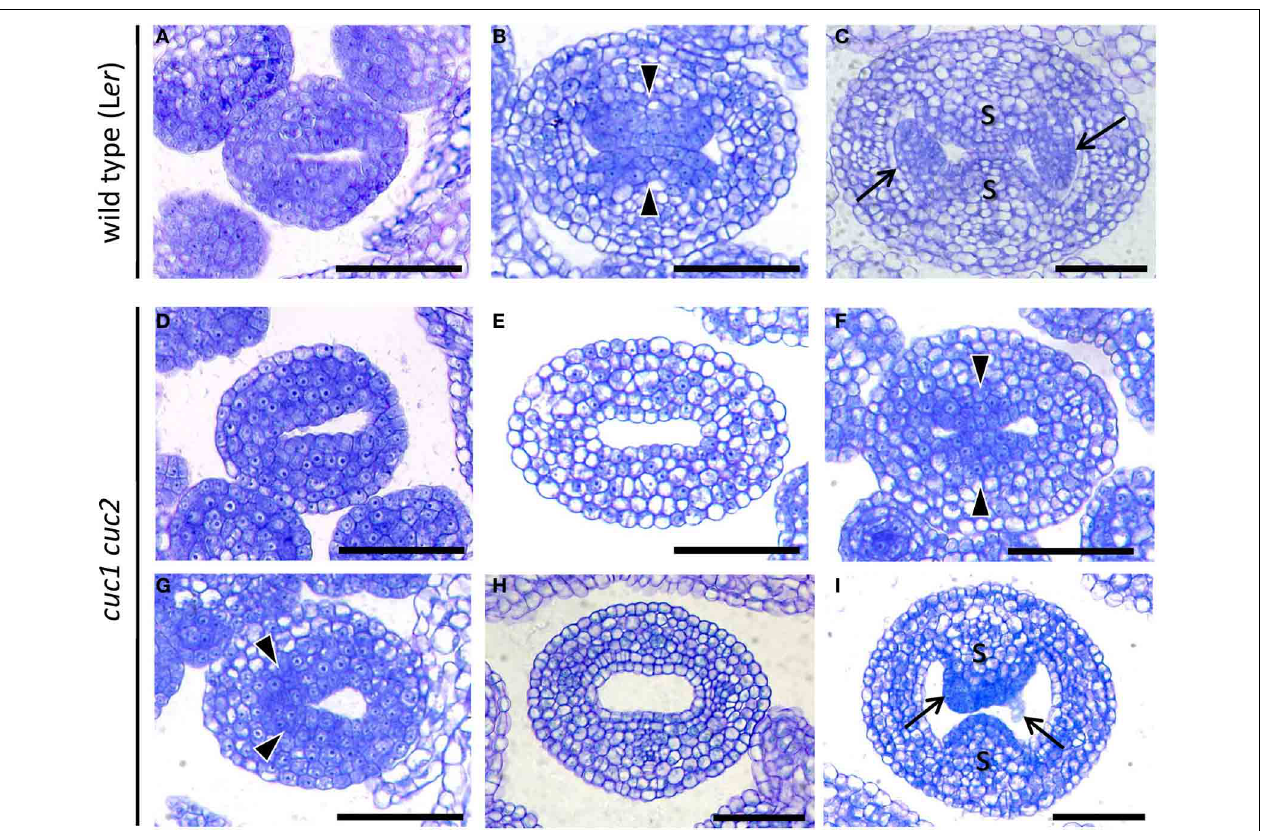
FIGURE 2 | CUC1 and CUC2 are required for formation and stable positioning of CMM. Transverse sections of developing gynoecium at stage 7 (A,D) , stage 8 (G) , early stage 9 (B,E,F) , mid stage 9 (H), and